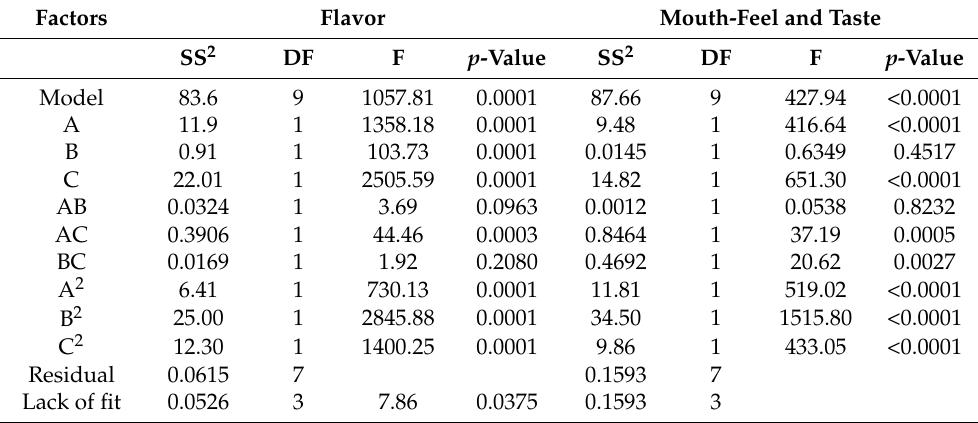
Table 2. Results of regression analysis of avocado fruit pulp incorporated juice (flavor, mouth feel and